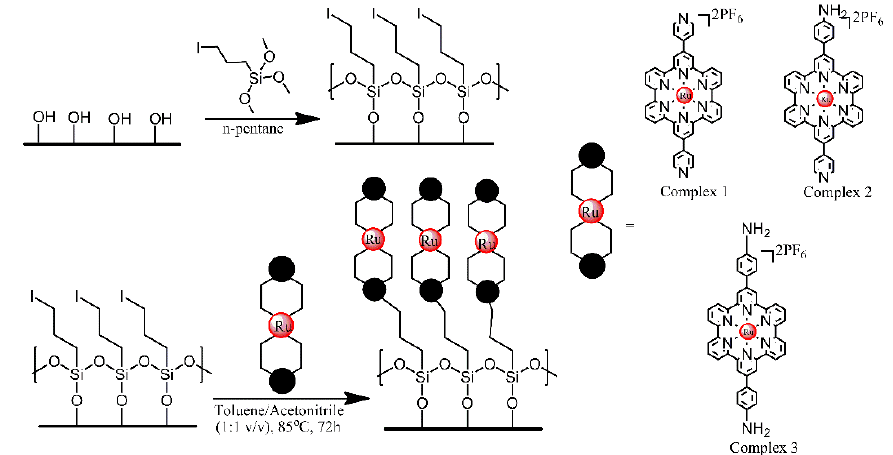
Figure 5. Schematic Representation of the Two-Step Fabrication Process for the Covalent Assembly of Functional Ru(II) Complexes 1−3 on Freshly Activated, Hydroxylated SiOx -Based Substrates